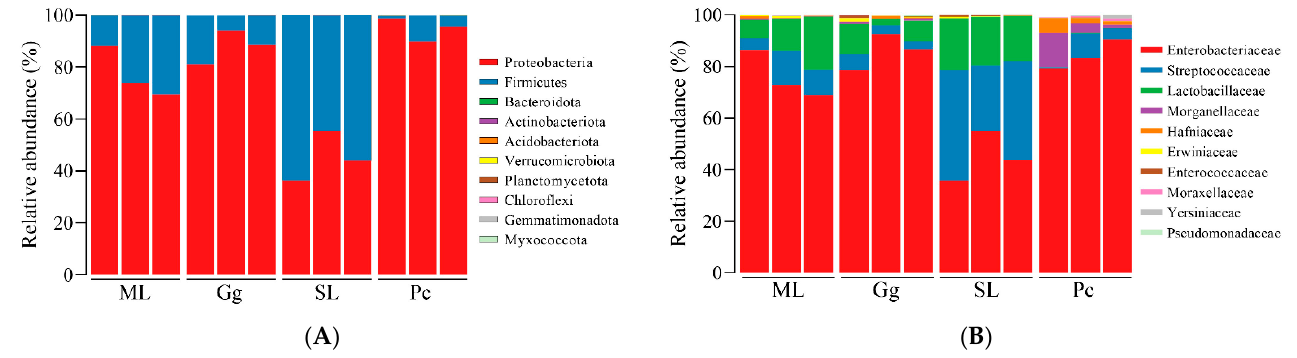
Figure 4. Bacterial composition of the top 10 relative abundances of bacteria at the phylum ( A ) and ( B ) family levels in the gut of Locusta migratoria manilensis fed on four different food plants. ML: maize leaves; Gg: goosegrass; SL: soybean leaves; Pc: pakchoi. Each color represents a phylum in ( A ) and a family in ( B ), and the height of the color block represents the proportion of relative abundance of that species.